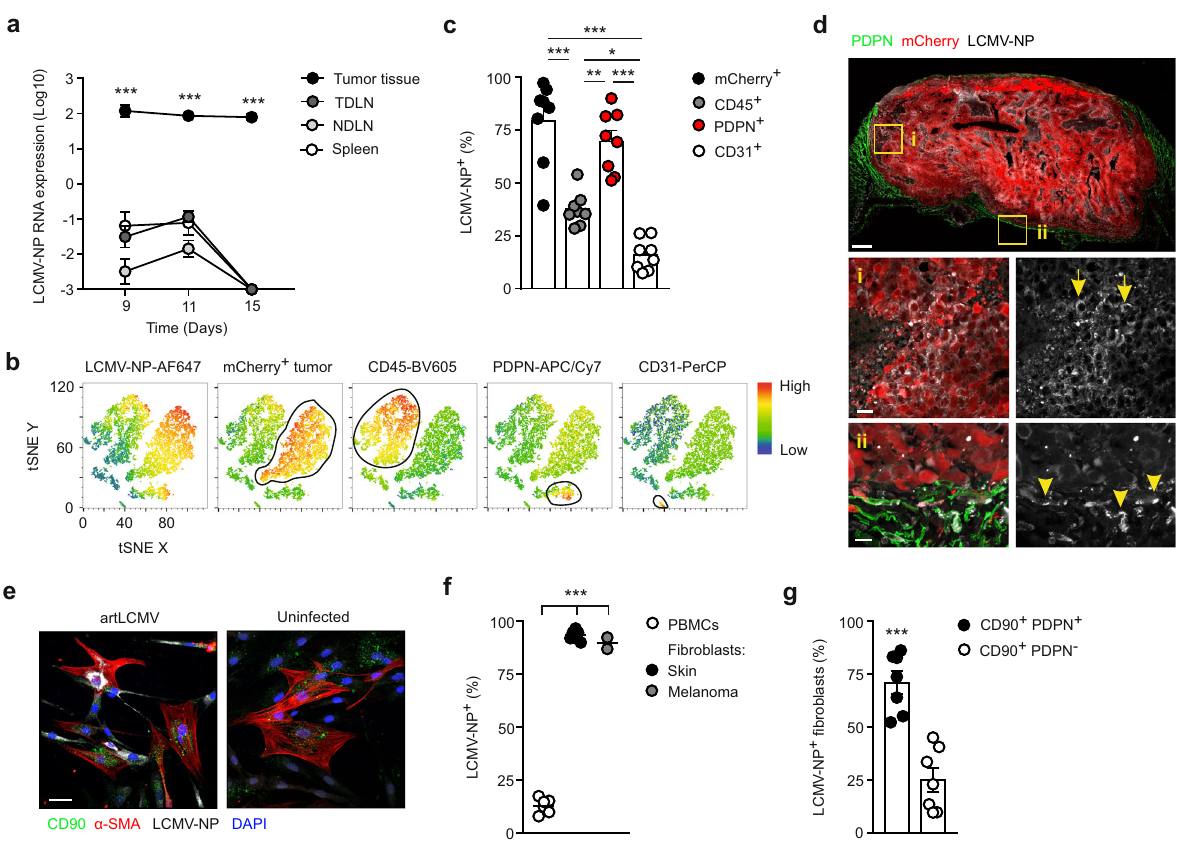
Fig. 3 Transduction of PDPN + FSCs in the TME by intratumoral artLCMV-TRP2 application. Mice were inoculated with B16F10-mCherry and immunized i.t. on day 7 with artLCMV-TRP2. a LCMV-NP RNA expression in tumor, tumor-draining, and non-draining lymph nodes (TDLN and NDLN) and spleen at indicated time points after i.t. artLCMV-TRP2 treatment. Dots indicate mean±s.e.m. for each time point. b , c Flow cytometric analysis with representative tSNE plot gated on viable Ter119 − cells on day 11. b Expression of indicated marker and c frequency of LCMV-NP + cells among identi fi ed cell populations in the TME including: mCherry + tumor cells, CD45 + immune cells, PDPN + FSCs, and CD31 + BECs. Dots represent individual mice and lines indicate mean values ± s.e.m values. d Representative confocal microscopy of tumors on day 11 following i.t. artLCMV-TRP2 injection from n = 3 mice. Representative areas are shown: (i) in the center of the tumor and (ii) in the tumor margin. Arrows and arrowheads indicate artLCMV-transduced cells by positive staining for LCMV-NP. Scale bar 1000 μ m (overview) and 10 μ m (boxed areas). e – g Infection of FSCs from human skin and melanoma biopsies with artLCMV. Scale bar 50 μ m. e Representative high resolution immuno fl uorescence images of artLCMV-transduced human skin-derived FSCs. f Frequency of LCMV- NP + cells. g Frequency of CD90 + PDPN + and CD90 + PDPN − cells among LCMV-NP + FSCs. Dots represent individuals and lines indicate mean values ± s. e.m values. Pooled data from two independent experiments with n = 11 mice ( a ) and n = 8 mice ( c ). Pooled data from n = 6 (PBMCs and Skin Fibroblasts) and n = 2 (Melanoma Fibroblasts) patients ( f ) and n = 7 patients ( g ). Statistical analysis was performed using two-way analysis of variance (ANOVA) with Bonferroni ( a ), one-way ANOVA with Tukey ’ s multiple comparison test ( c ), or unpaired two-tailed Student ’ s t test ( f , g ) with * P < 0.05: ** P < 0.01; *** P < 0.001. Source data and exact P values are provided in the Source data fi